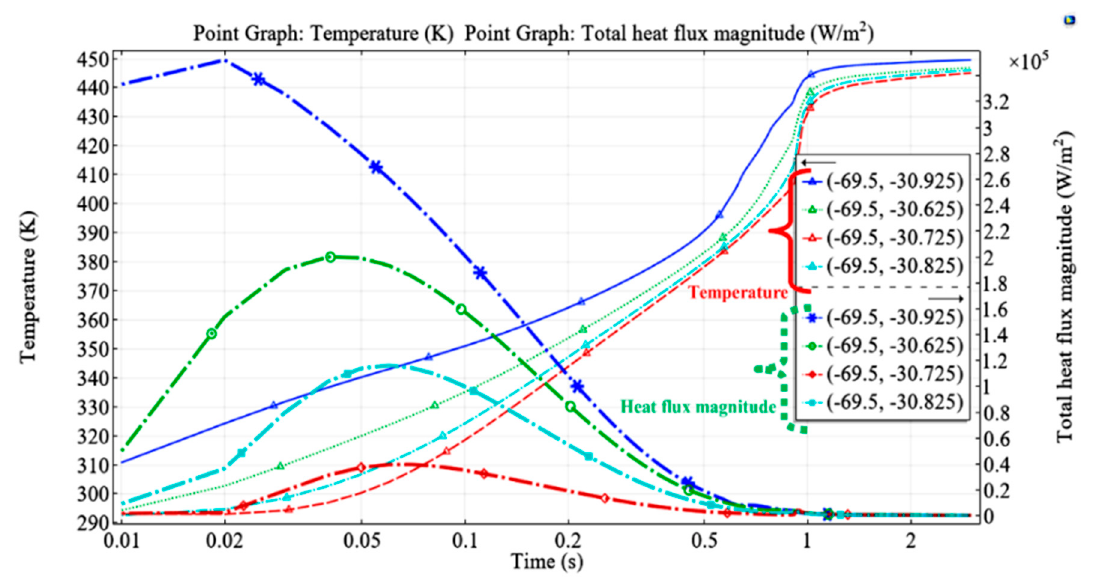
Figure 15. Heat flux with increasing temperature on channel walls at different points varying with the time.